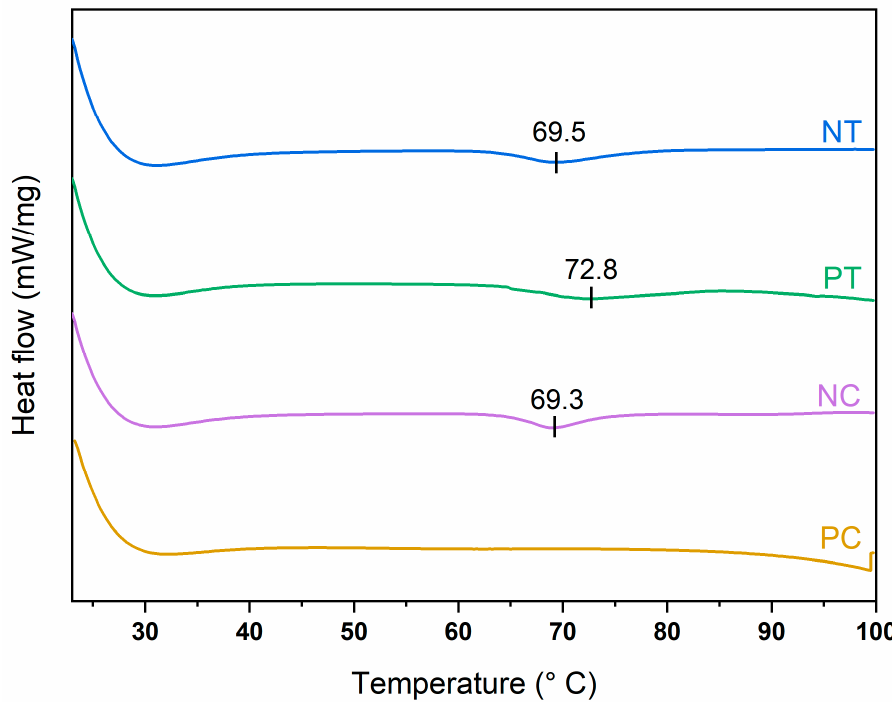
Figure 2. DSC graphs of the four starches: NT, native tapioca; PT, pregelatinized tapioca; NC, native corn; PC, pregelatinized corn.